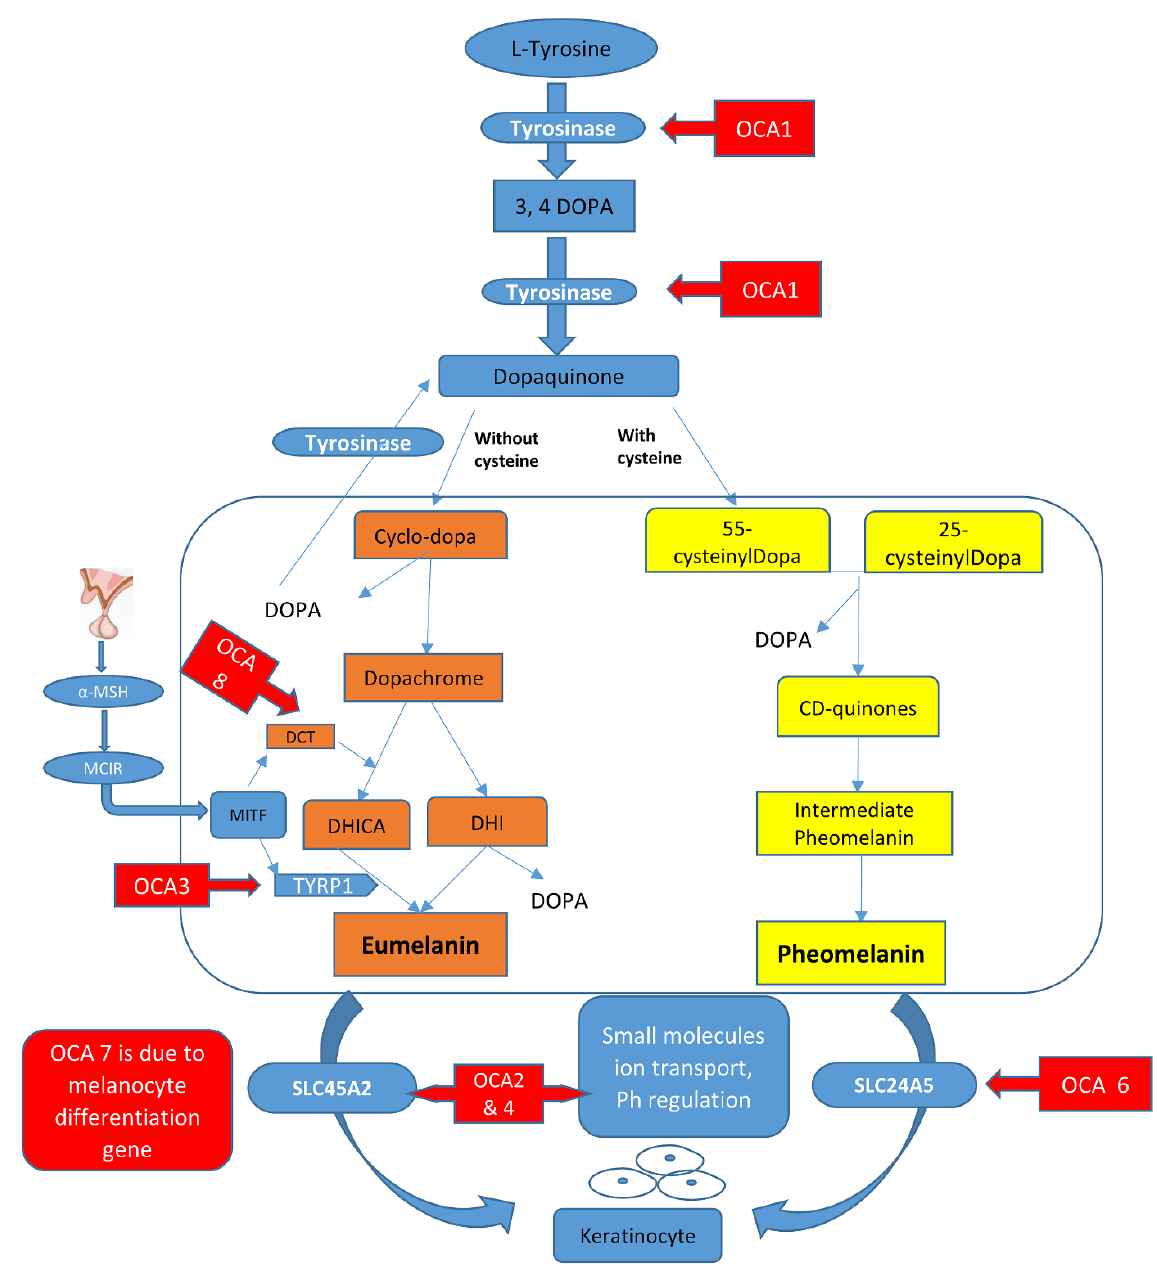
Figure 1. Graphical representation of the melanin synthesis pathway and rate-limiting steps that if defective lead to OCA